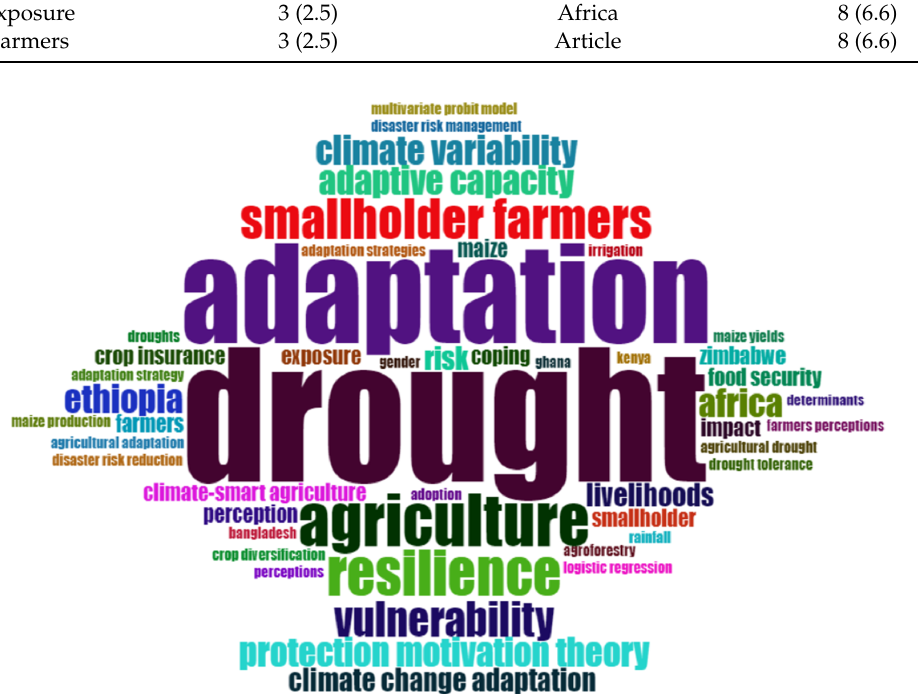
Figure 5. Word cloud showing the top 50 most often used authors’ keywords in PASSFDR publications indexed in Scopus (2011–2020) .